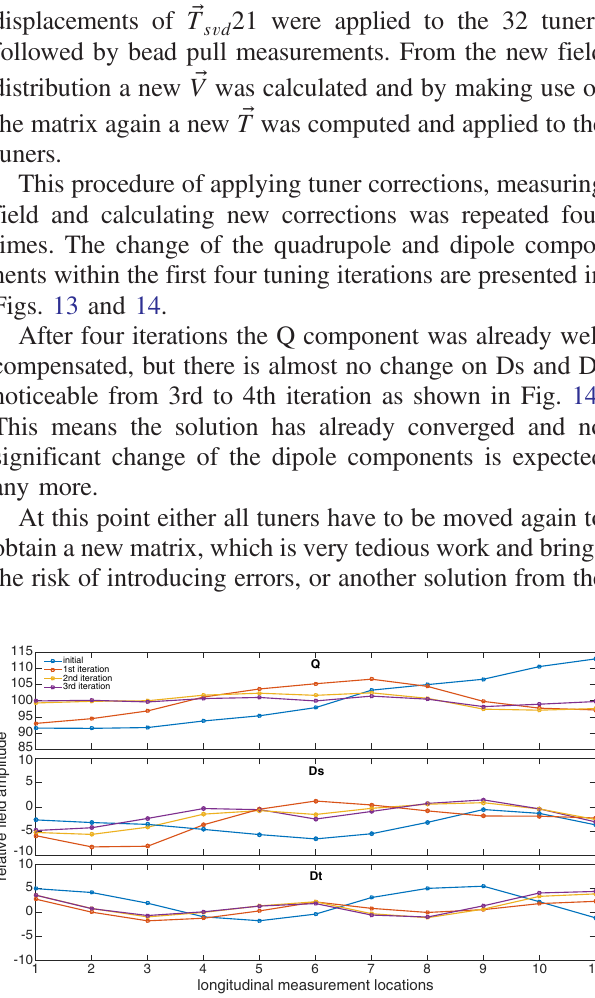
FIG. 13. The plot shows the change of the field distribution of the Q, Ds, and Dt components for the initial state as well as for the 1st, 2nd, and 3rd tuning iteration.